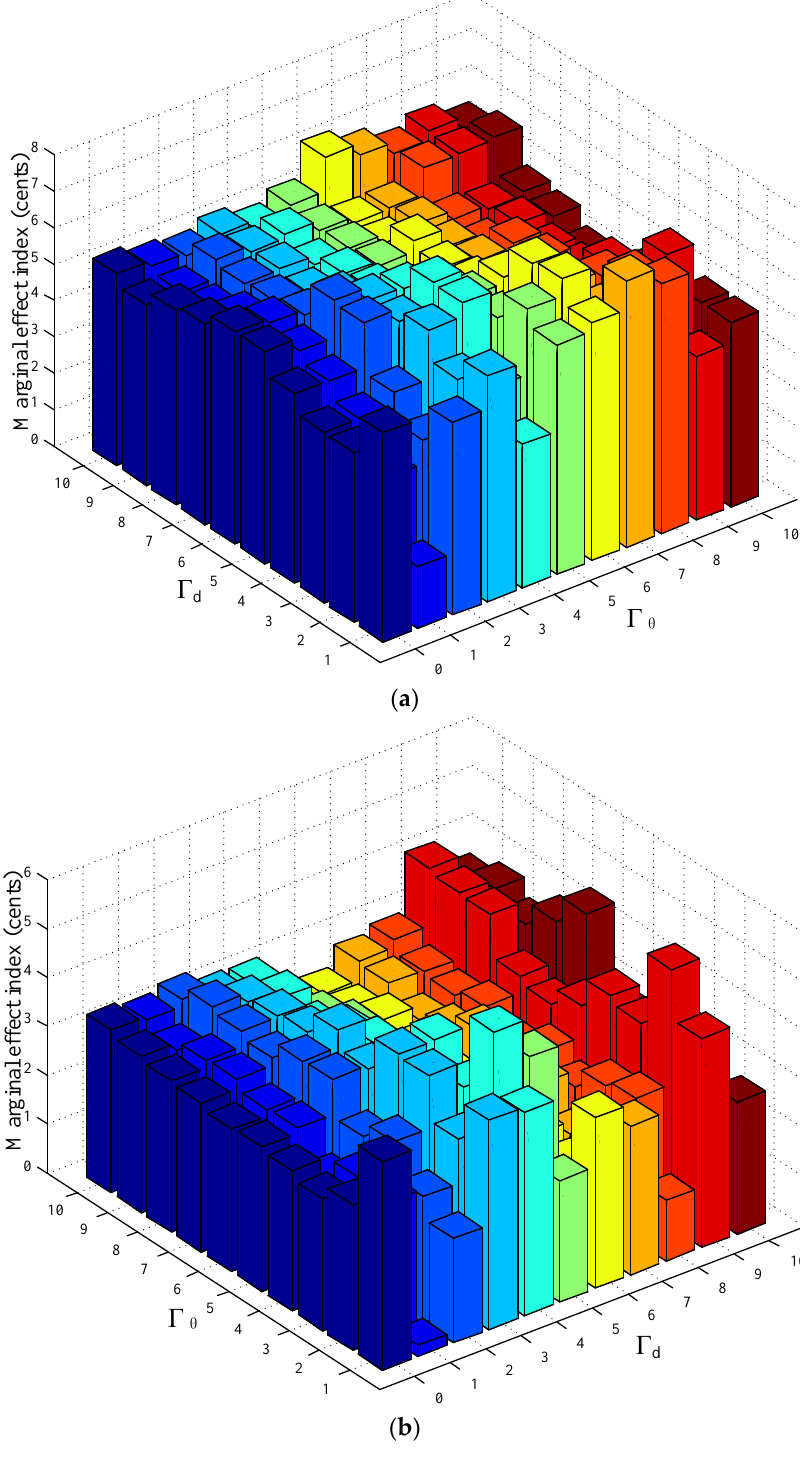
 ; ( b ) under different values of  d  under different values of  .  d